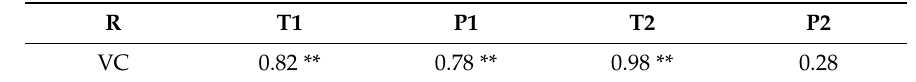
Table 7. Correlation coe ffi cients between VC and the temperature and precipitation cumulative anomalies at the Ejin Horo and Shenmu